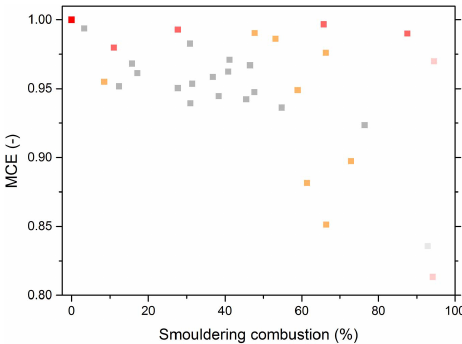
Figure 10. A scatter plot of MCE vs. the percentage area of the combusting fuel bed undergoing smouldering combustion. The same colour gradation scheme from Fig. 6 is used to denote differ- ent combustion phases. The first data point is nearly coincidental (i.e. MCE approximately 1) for all three fire spread modes, which is why only one symbol is